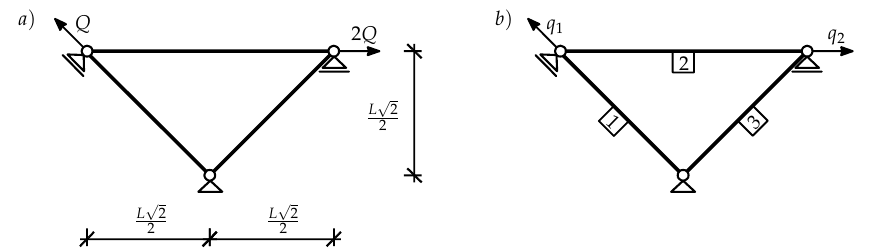
Figure 2. Truss geometry and supports with ( a ) loads and ( b ) degrees of